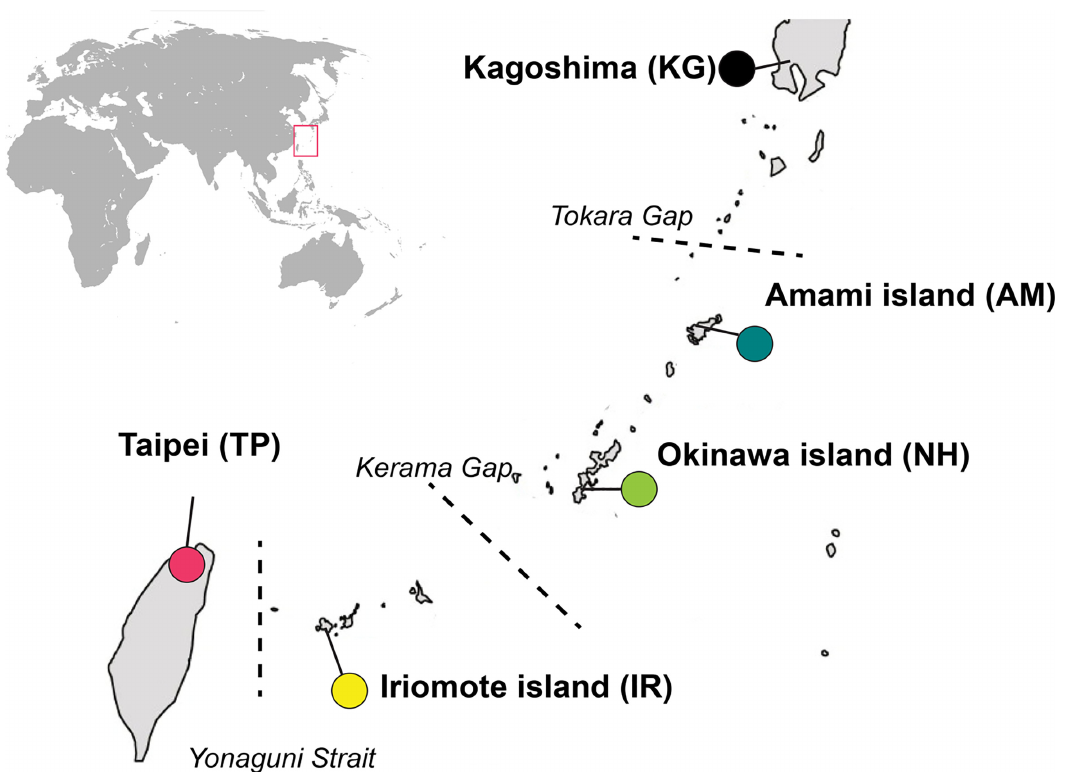
Fig 2. Map of the Ryukyu archipelago and Taiwan with the position of the collection sites. Colored circles denote collection sites. Location abbreviations are given in the brackets. Tokara, Kerama, and Yonaguni straits are roughly indicated by dashed lines.